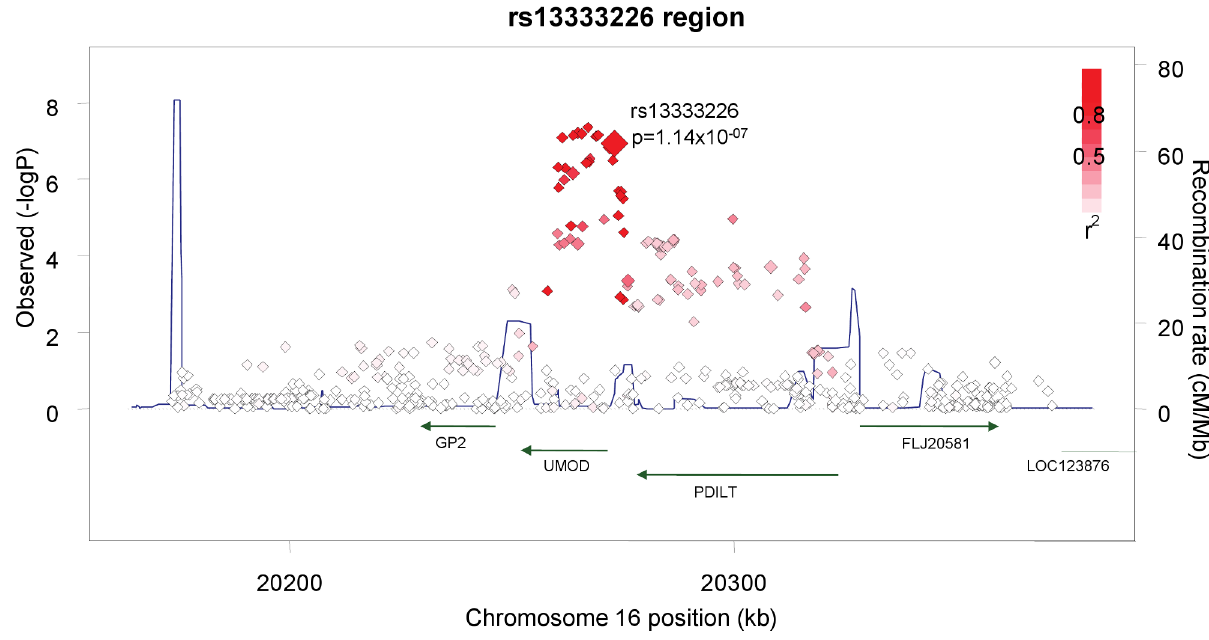
Figure 3. Association plot of the genomic region around rs13333226 showing both typed and imputed SNPs with location of genes and recombination